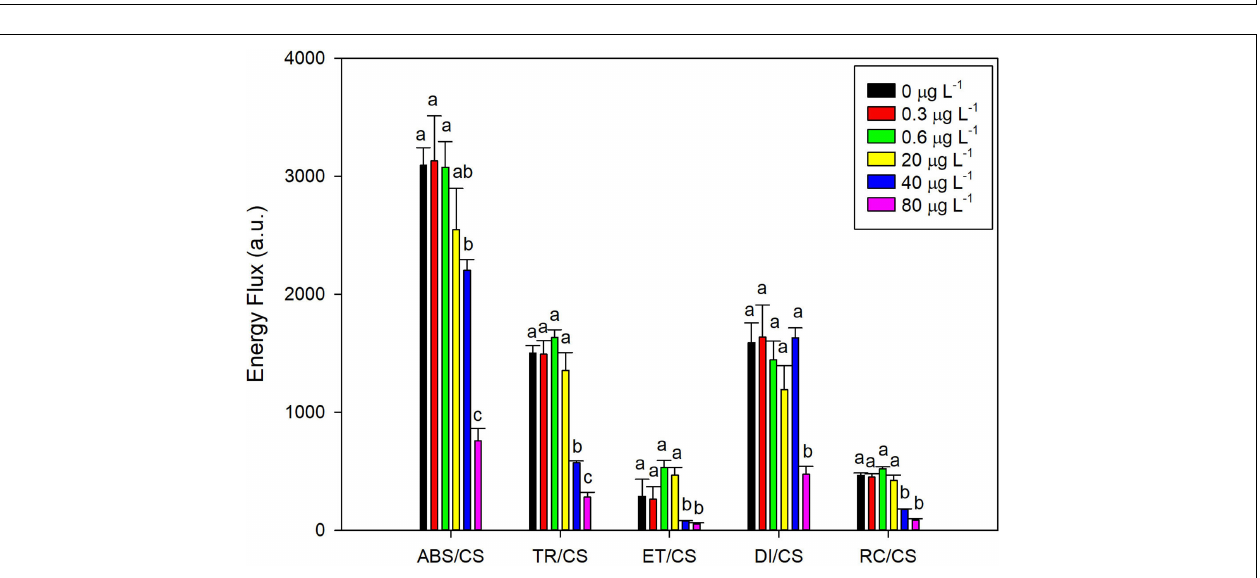
FIGURE 1 | Cell density (A) and relative cell density reduction toward the control (B) of Phaeodactylum tricornutum following a 48 h exposure to different fluoxetine concentrations. X -axis in (A) includes the whole experiment duration from algae inoculation (0 h) to fluoxetine exposure (48 h) and cell harvest (96 h) and storage. Arrow points to the moment of initial fluoxetine exposure of P. tricornutum cells. Average ± standard deviation.